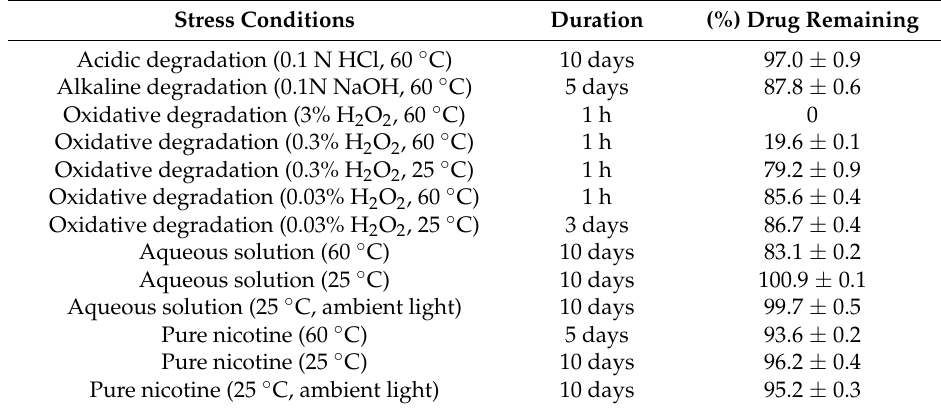
Table 1. Stress studies of nicotine showing % nicotine remaining after exposed to various stressed conditions.